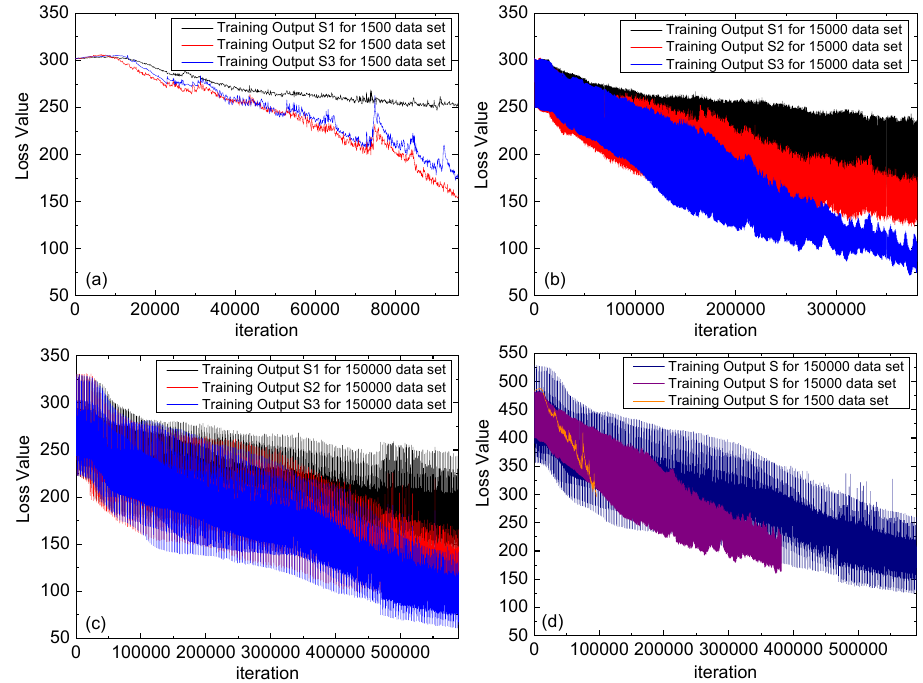
Figure 3. The loss value curve for the training process on the training data set of ( a ) 1500 ( b ) 15,000 and ( c ) 150,000. ( d ) The loss value curve comparison of the output result S for three training data set.